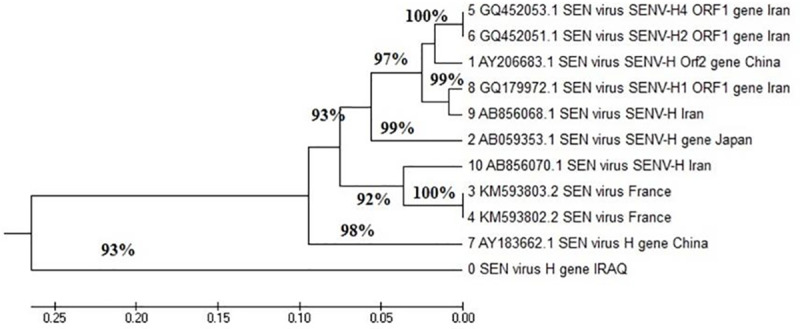
Phylogenetic tree analysis of the genetic distance between the Iraqi SEN virus H genotype and other sequences deposited in GenBank.